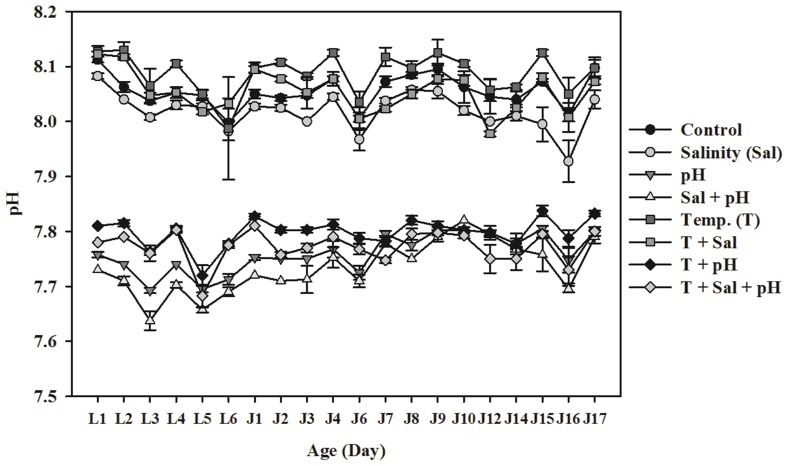
Mean pH (NBS scale) change during the experiment.The mean ± SD of four replicates. Abbreviations are L1–L6: Day 1–6 of larval growth phase; J1–J17: Day 1–17 of post-settlement juvenile/adult growth phase; Control (pH 8.1, Salinity 34‰ Temperature 23°C); Salinity (pH 8.1, Salinity 27‰ and Temperature 23°C); Temperature (pH 8.1, Salinity 34‰ and Temperature 29°C); pH×Sal: 7.8 and 27; pH×T: 7.8 and 29; Sal×T: 27×29; pH×Sal×T: 7.8×27×29.